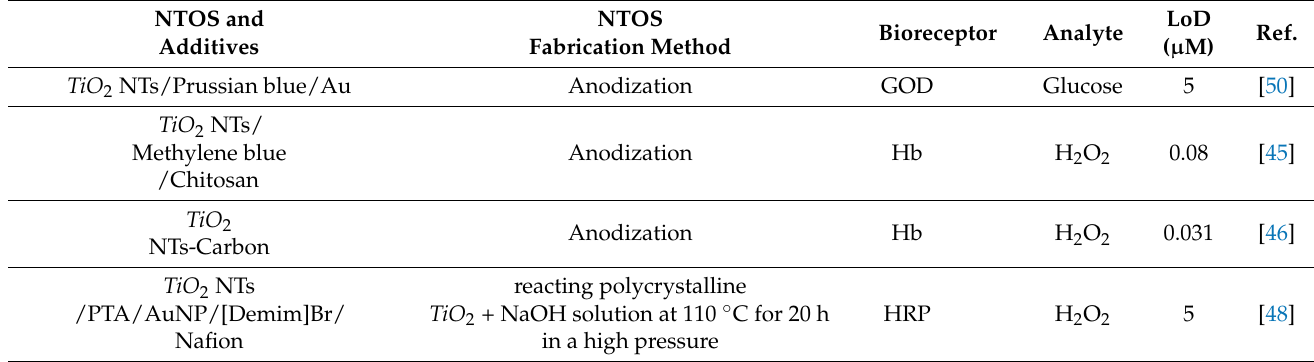
Table 2. Voltammetric/Amperometric biosensors based on